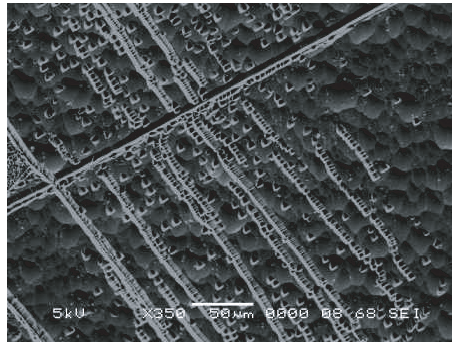
Figure 4: Formation of dislocation lines perpendicular to the grain